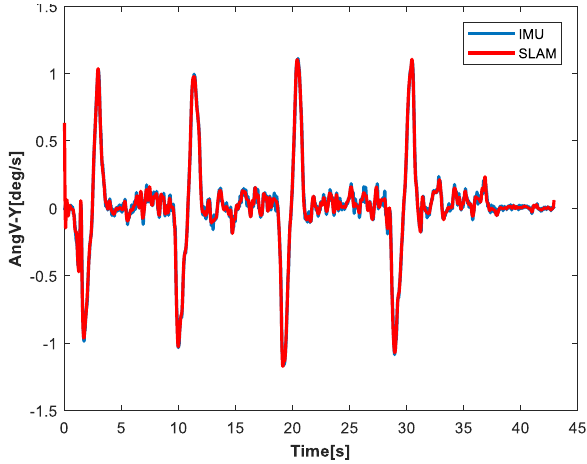
Figure 2. An example plot for testing the IMU integration. The angular velocities measured by the IMU along the y-axis are plotted against the first-order derivatives of the rotation y-splines estimated by the laser-based SLAM. Similar tests were done for all axes of the